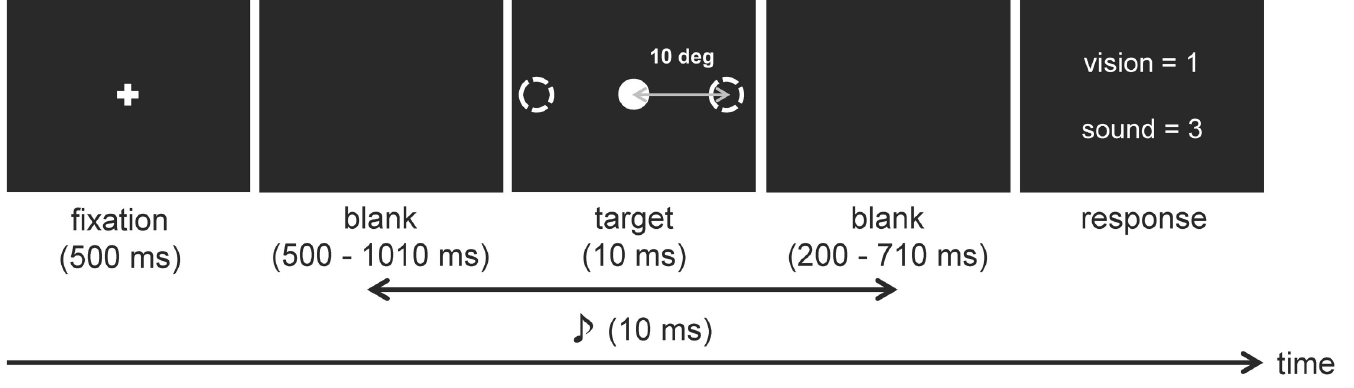
Fig 1. The schematic representation of the procedure used in the temporal order judgment